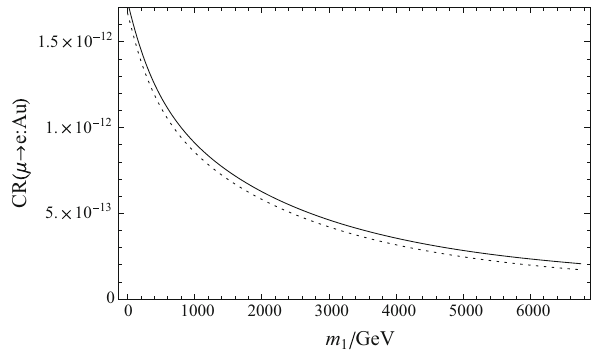
Fig. 4 With m 1 = 500GeV, m 2 = 1000GeV , M Lf = 10 4 GeV 2 , V Lt = 3000GeV, tan β L = 2 . 0, and g L = 1 , μ → e conversion rate in μ → e conversion rate in nuclei Au versus tan β with S 2 6 (solid line) and 16TeV 2 (dotted line)